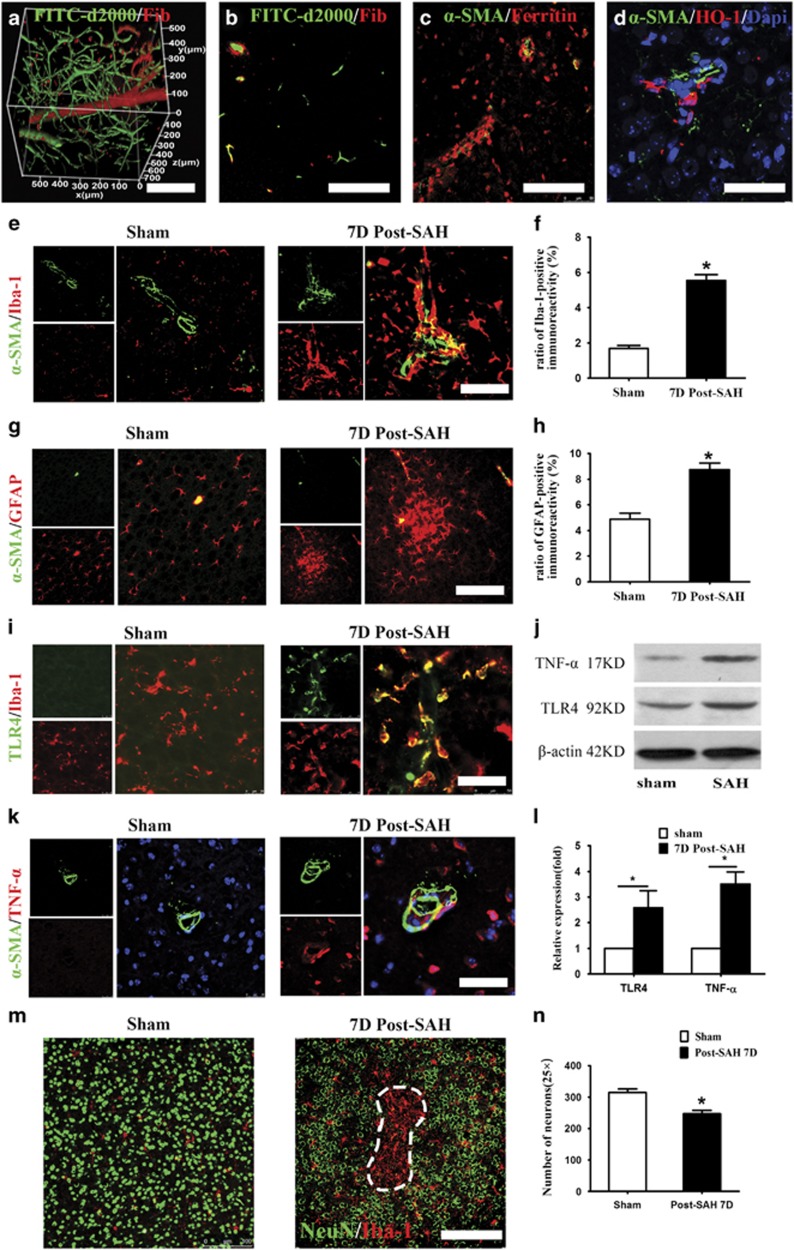
Influx of blood components via the paravascular pathway induces neuroinflammation and microcirculation dysfunction in the perivascular parenchyma after SAH. (a) Representative CLARITY images spatially showing the deposition of fibrinogen (red) in the extravascular zone along penetrating arterioles and their collaterals (labeled by intravenous injection of FITC-d2000) at 1 h after SAH. (b) A representative image under high magnifications showing the distribution of fibrinogen in the extravascular space surrounding the penetrating arteriole. (c) Immunostaining on brain sections showing the presence of ferritin in the perivascular parenchyma on day 7 after SAH. (d) Immunostaining on brain sections showing the expression of heme oxygenase-1 (HO-1) in the perivascular parenchyma on day 7 after SAH. (e and f) Microglial cells were pronouncedly activated in the perivascular parenchyma on day 7 after SAH (n=5, *P<0.05). (g and h) Astrocytes were pronouncedly activated in the perivascular parenchyma on day 7 after SAH (n=5, *P<0.05). (i) Representative images showing that activated microglial cells express TLR4 on day 7 after SAH. (j) Representative images showing higher expression of TNF-α in the perivascular parenchyma in SAH animals compared with the animals with sham surgery. (k and l) Western-blot analyses demonstrating significantly increased expression of TLR4 and TNF-α in the SAH animals compared with the animals with sham surgery (n=5, *P<0.05). (m) Representative images showing the cortical microinfarct with distinct infarction cores that were occupied by activated microglial cells and were devoid of neurons. (n) Quantitative analyses showed that the number of neurons in the cortex of SAH mice significantly decreased compared with the Sham n=5, *P<0.05). Scale bar: 200 μm (a, b, c, g and m); and 75 μm (d, e, i and k)